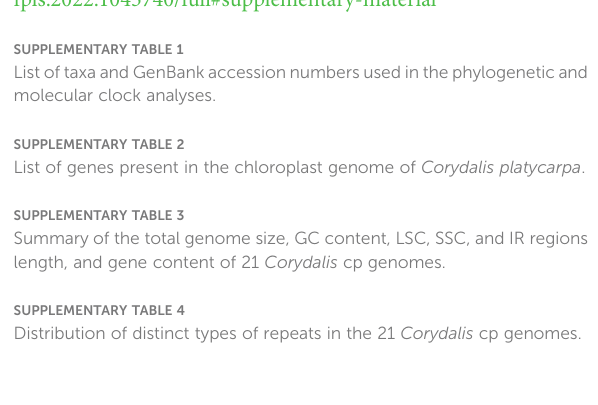
SUPPLEMENTARY TABLE 3 Summary of the total genome size, GC content, LSC, SSC, and IR regions length, and gene content of 21 Corydalis cp genomes. SUPPLEMENTARY TABLE 4 Distribution of distinct types of repeats in the 21 Corydalis cp genomes.